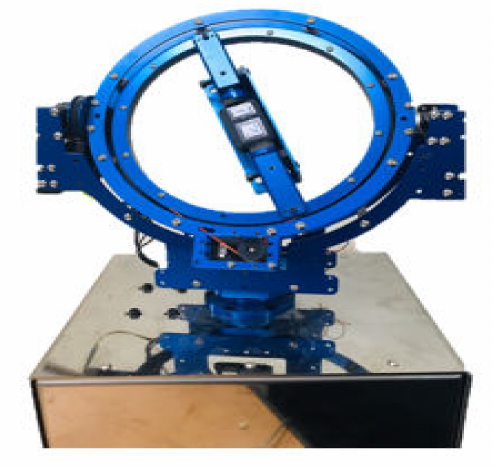
Figure 2. Gimbal device.